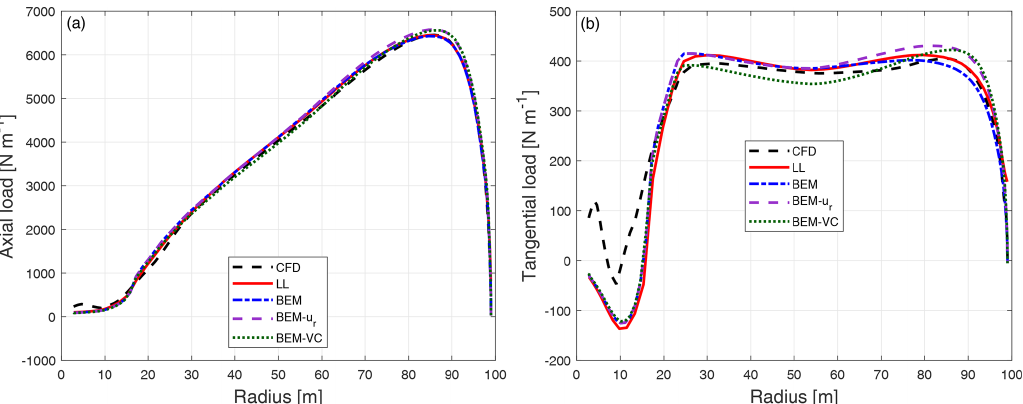
Figure 11. Comparison of axial load (a) and tangential load (b) of the dihedral blade W-1 calculated from CFD, the lifting-line method (LL), the BEM method, BEM with radial induction (BEM- u r ) and the proposed BEM-VC method.